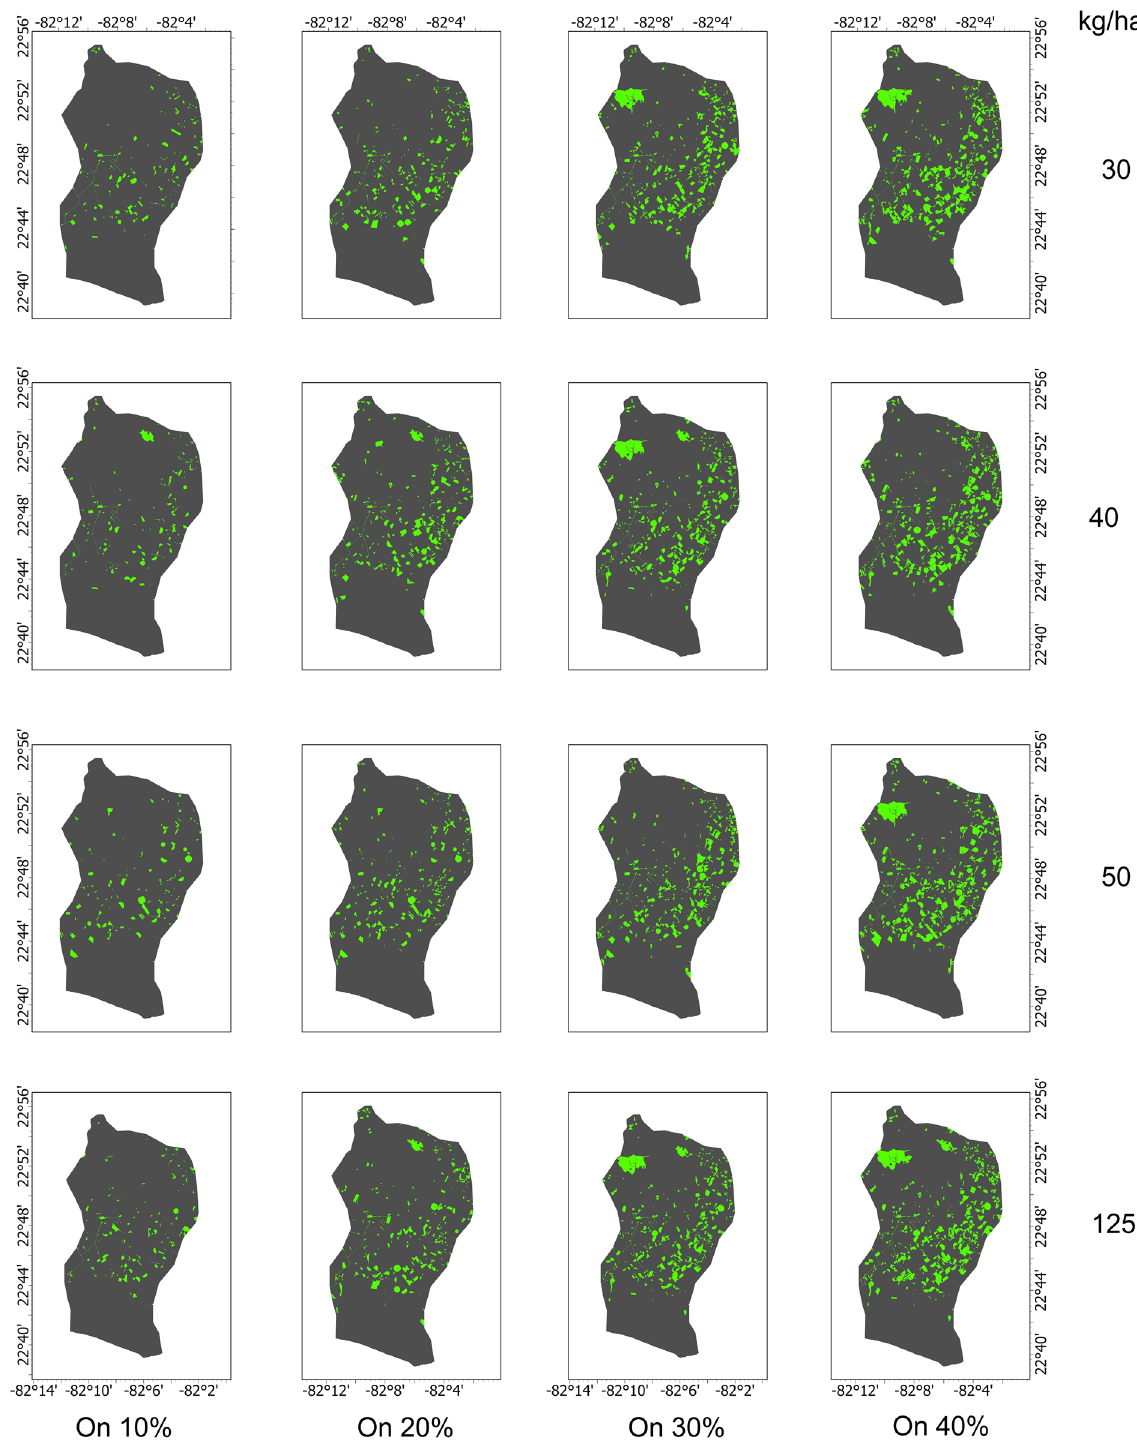
Fig. 15 Spatial distribution of the treatments in crops with the highest nutrients export to the Gulf of